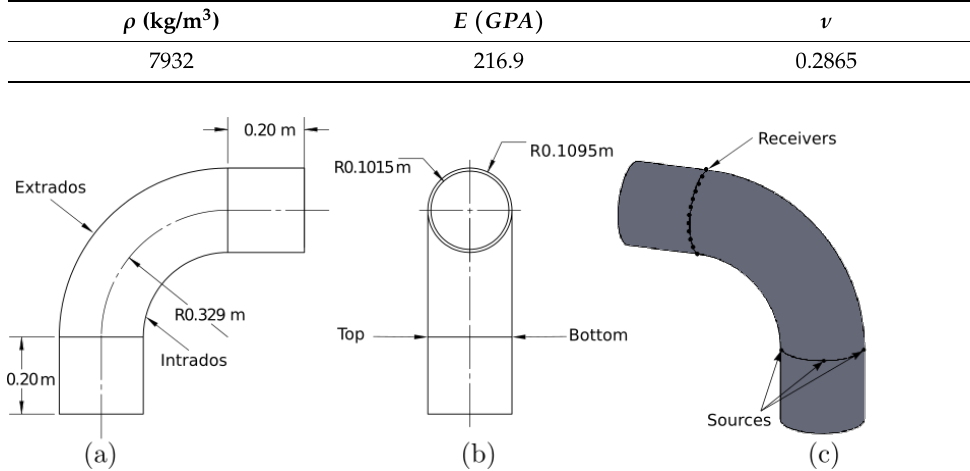
Table 1. Steel pipe material properties. Density ρ , Young’s modulus E , and Poisson ratio ν .